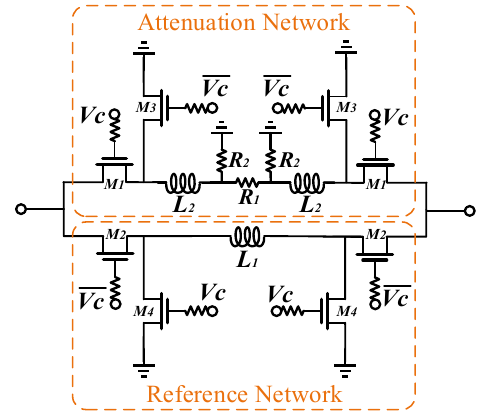
Figure 11. The schematic of the switched-path attenuation cell. In order to better regulate the phase error in the broadband, the proposed switched- path type attenuation cell uses a series inductor 𝐿 1 in the reference state and two series inductors 𝐿 2 with three resistors in the attenuation state, as shown in Figure 11. This structure provides more freedom for the phase regulation of the attenuation cell, making it easier to achieve phase balance. In addition, this topology is desired to ensure two en- tirely independent paths, i.e., one path should be completely cut off while the other path is working. Therefore, the off-isolation of the two paths seems particularly important. In the design of this paper, two leakage switches, 𝑀 3 and 𝑀 4 , are added to the reference and attenuation paths of the switched-path attenuation cell, respectively, as shown in Fig- ure 11. To ensure that the signal can be effectively leaked when the path is cut off, 𝑀 3 and 𝑀 4 are in opposite states to 𝑀 1 and 𝑀 2 , respectively. In this way, it is possible to ensure that the signal passes through only one path, making the phase variation smaller and achieving a broadband balance of phases. The phase variation between the reference state and the attenuation state of the switched-path attenuation cell is shown in Figure 12, which shows that the two paths both have similar phase variations and a small relative phase. Figure 12. The phase variation between the reference state and the attenuation state of the switched − path attenuation cell. 2.4. Cascade of Attenuation Cells The design of the attenuator should ensure that each attenuation cell has an accurate attenuation level, a small phase variation, and a wide bandwidth. The performance of each cell will eventually affect the root-mean-square (RMS) attenuation error, bandwidth, etc. of the whole attenuator. The 6-bit DSA designed in this paper is shown in Figure 13,